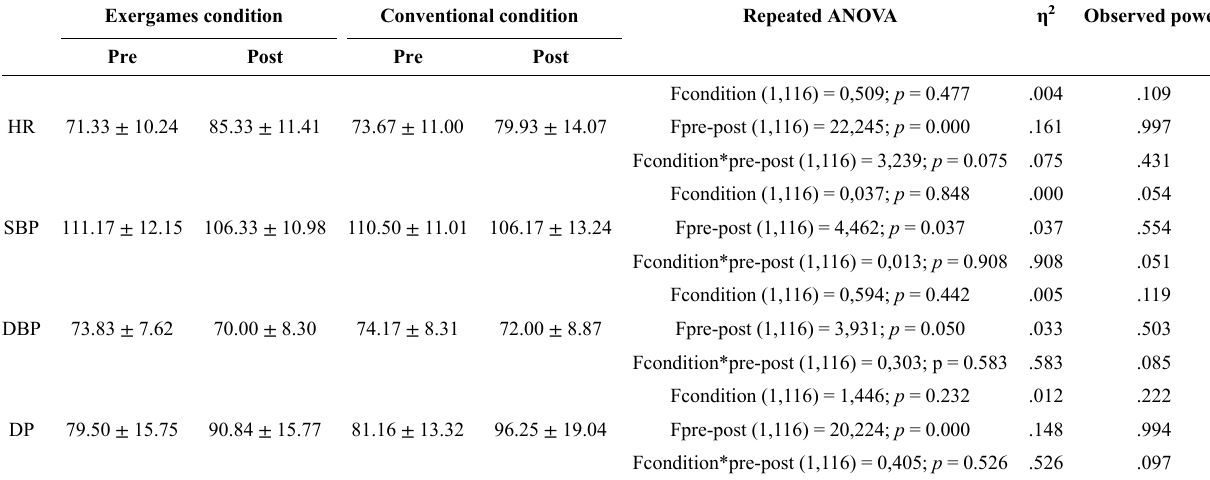
Table 1 - Group characterization with mean, standard deviation, and test